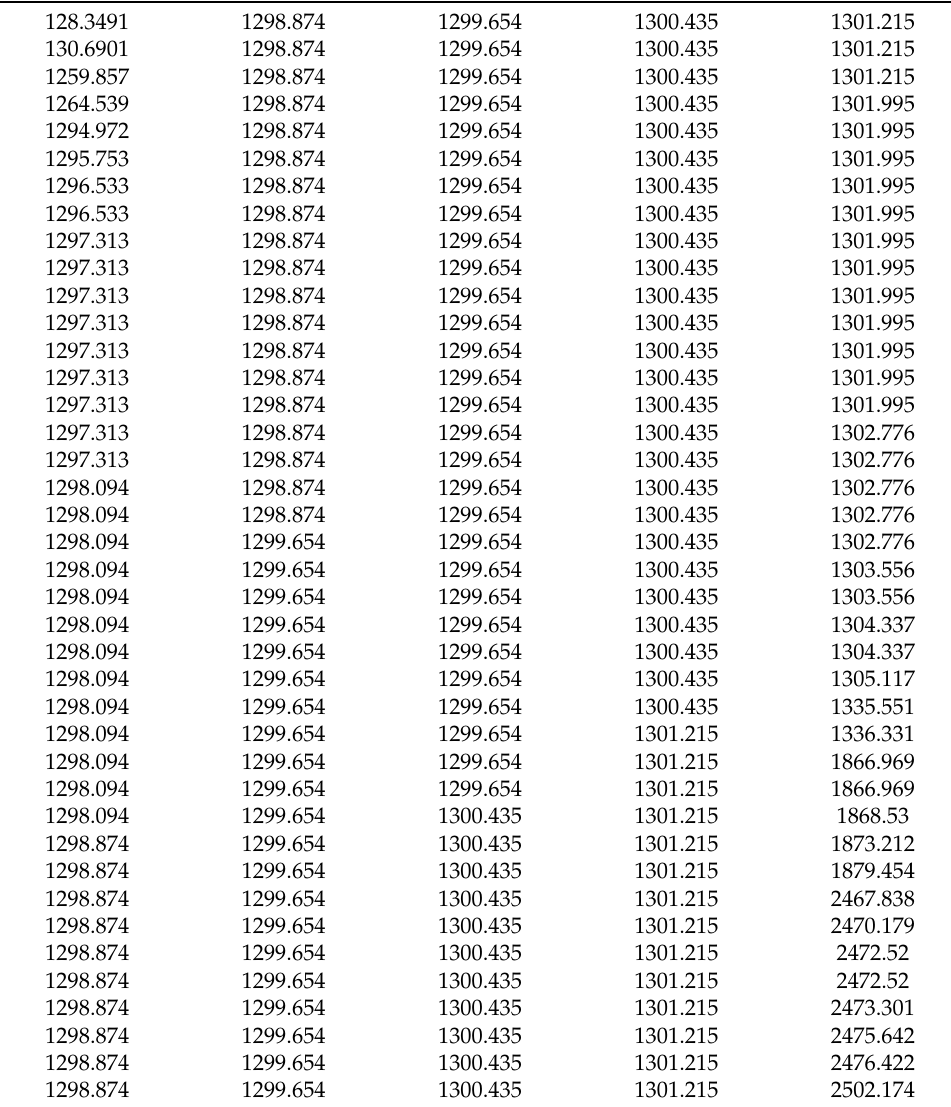
Table 3. The 200 estimated PD locations for the trimming